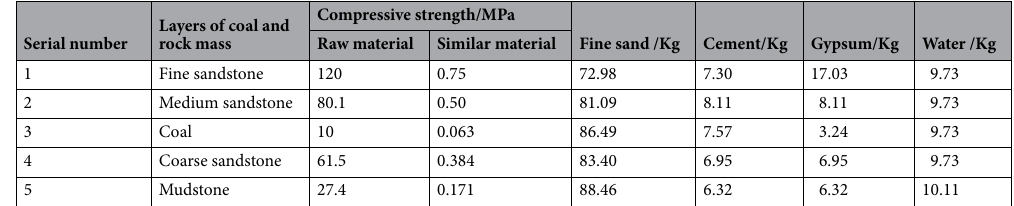
Table 5. The composition and ratio of similar materials of each layer.